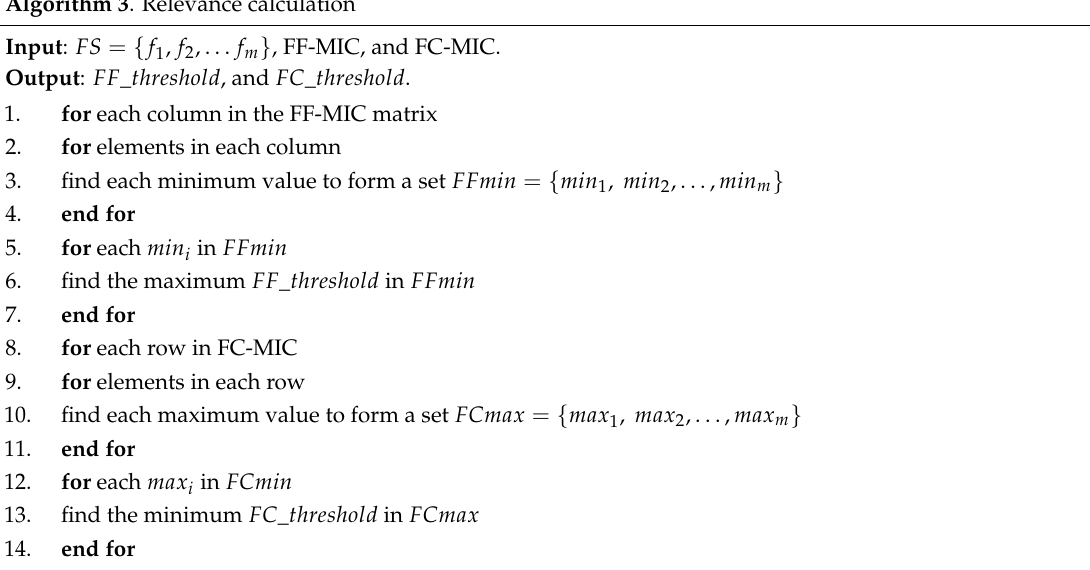
Algorithm 3 . Relevance calculation